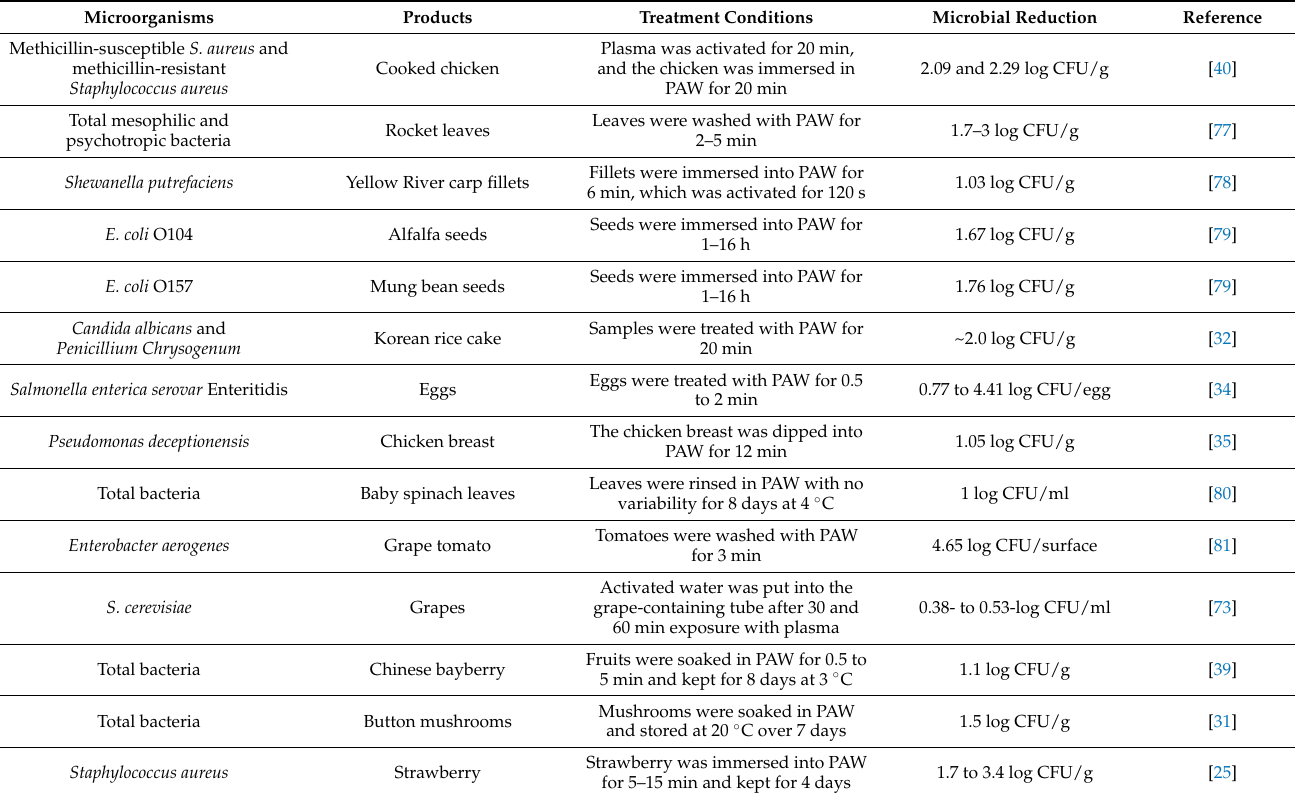
Table 1. The impact of plasma-activated water on microorganism